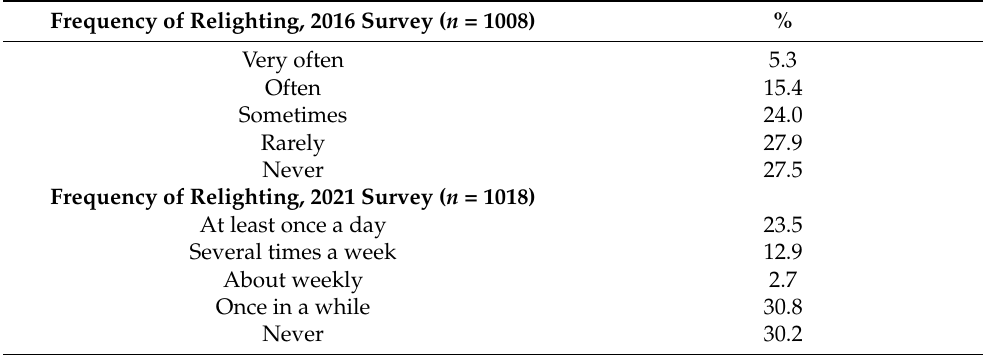
Table 1. Frequency of relighting behaviors among current adult smokers in two national US surveys.